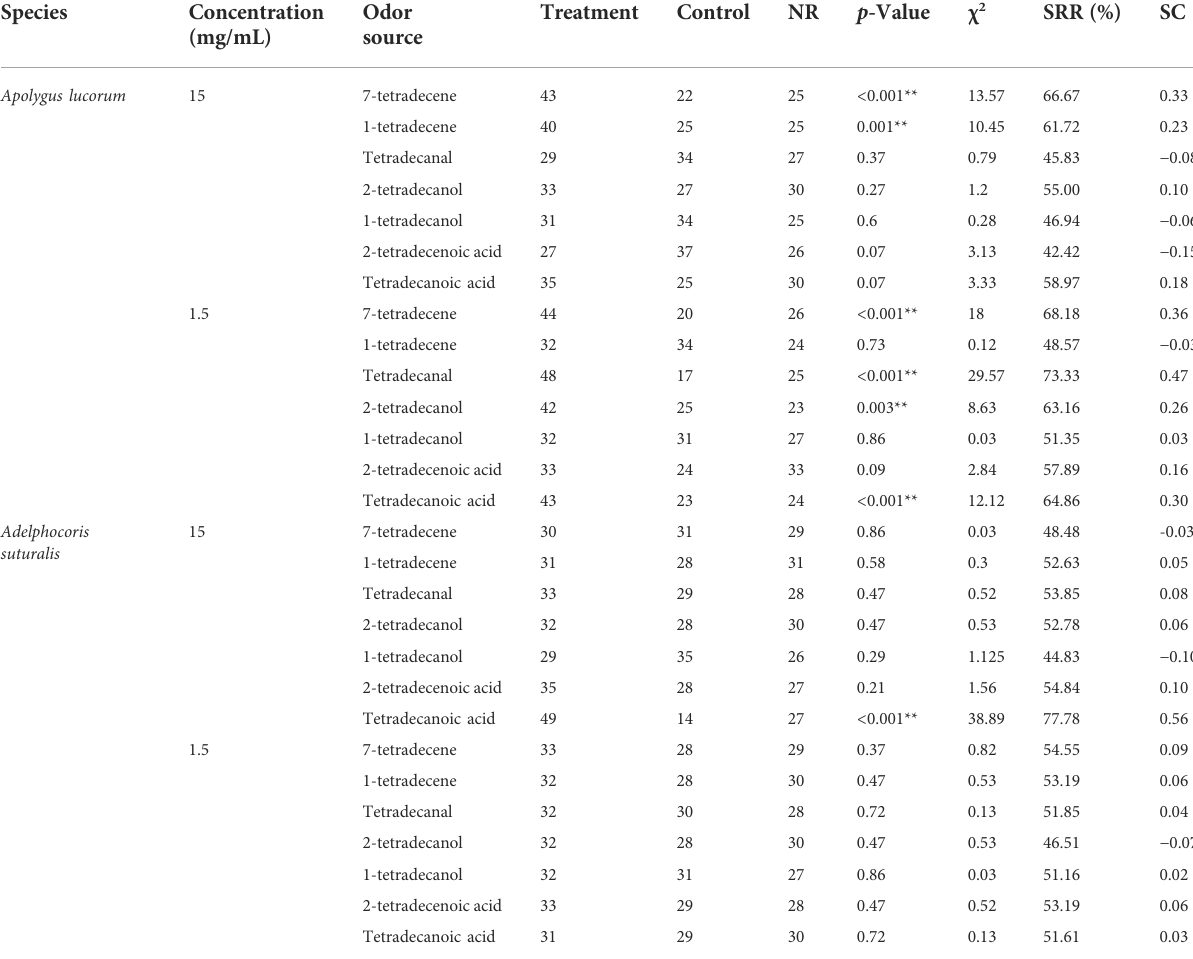
TABLE 3 The olfactory responses of two pest mirid bugs to synthetictetradecane derivatives, measured in laboratory tests.